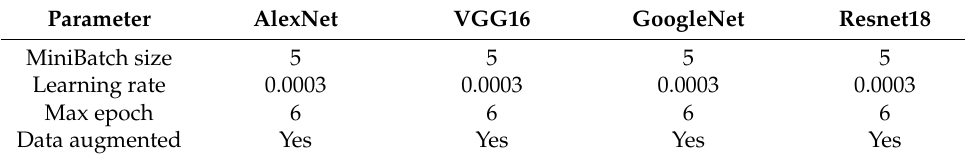
Table 2. Training Parameter Used for Identification of Trash.